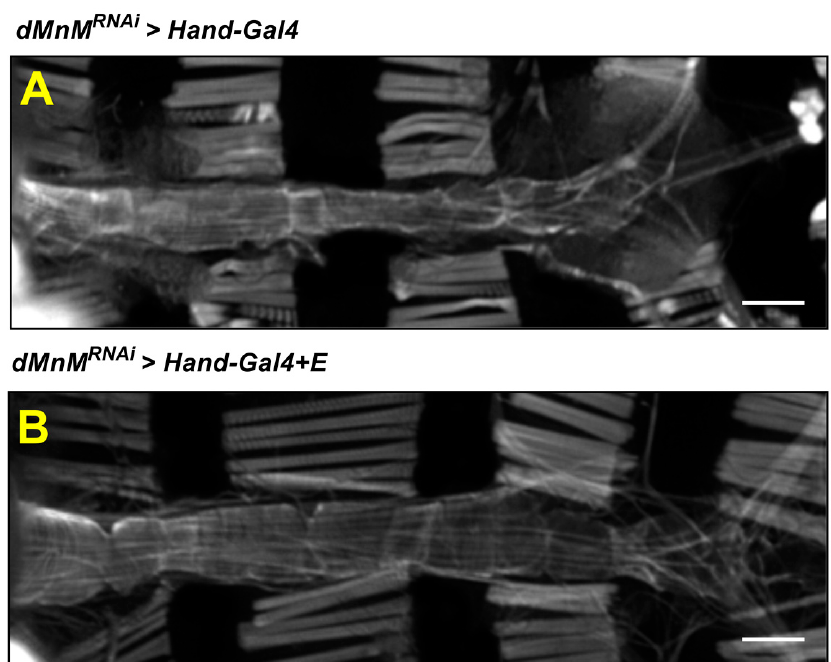
Figure 6. Effect of regular exercise on F-actin in myogenic fibers of cardiac myocytes after dMnM knockdown. ( A ) Fluorescence images of the heart in the dMnM RNAi > Hand-Gal4 group. ( B ) Fluorescence images of the heart in the dMnM RNAi > Hand-Gal4 + E group, n = 5. F-actin was labeled with ghostwritten cyclic peptide. Confocal microscopy was used to observe the changes in the Drosophila heart tube.